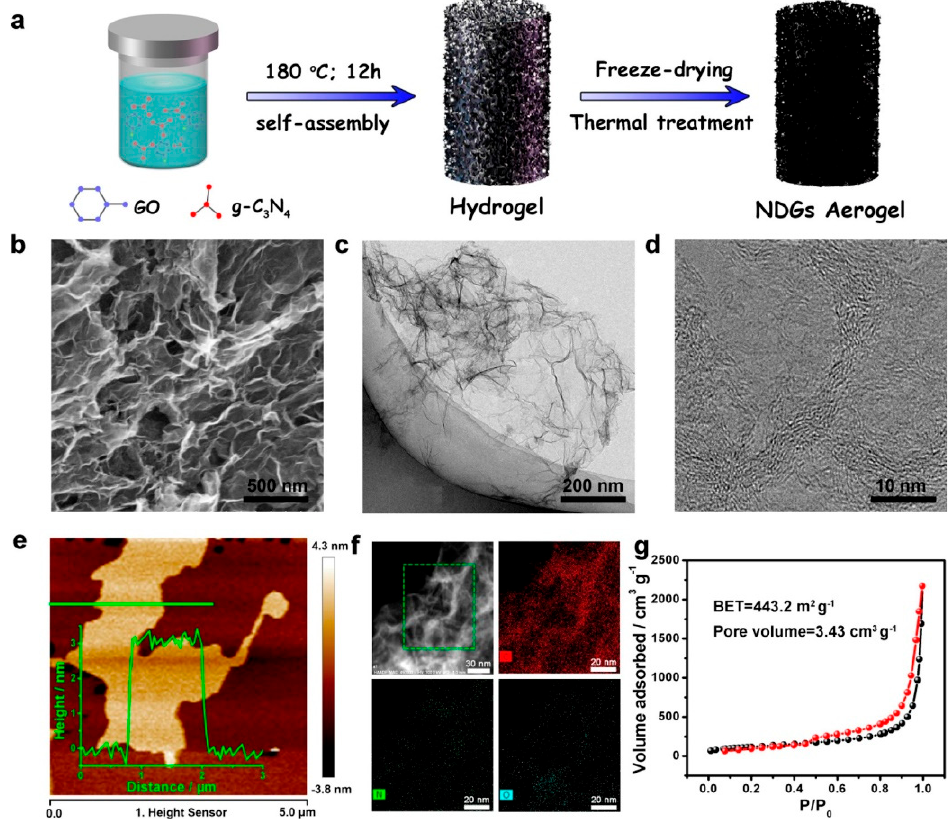
Figure 4. ( a ) Scheme of sample synthesis. ( b ) SEM, ( c ) TEM, ( d ) HRTEM, ( e ) AFM image, ( f ) elemental mapping images, and ( g ) N 2 adsorption–desorption isotherms of a representative sample. Adapted from [72], with permission from ACS Energy Letters, 2018.